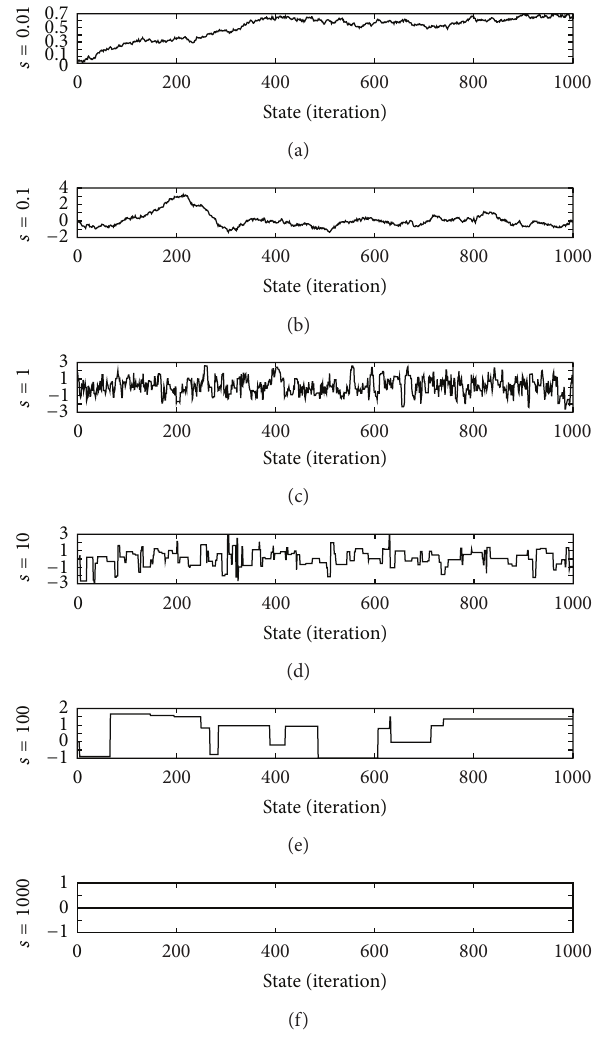
Figure 4: Example of 1-dimensional Monte Carlo Markovian algorithm.